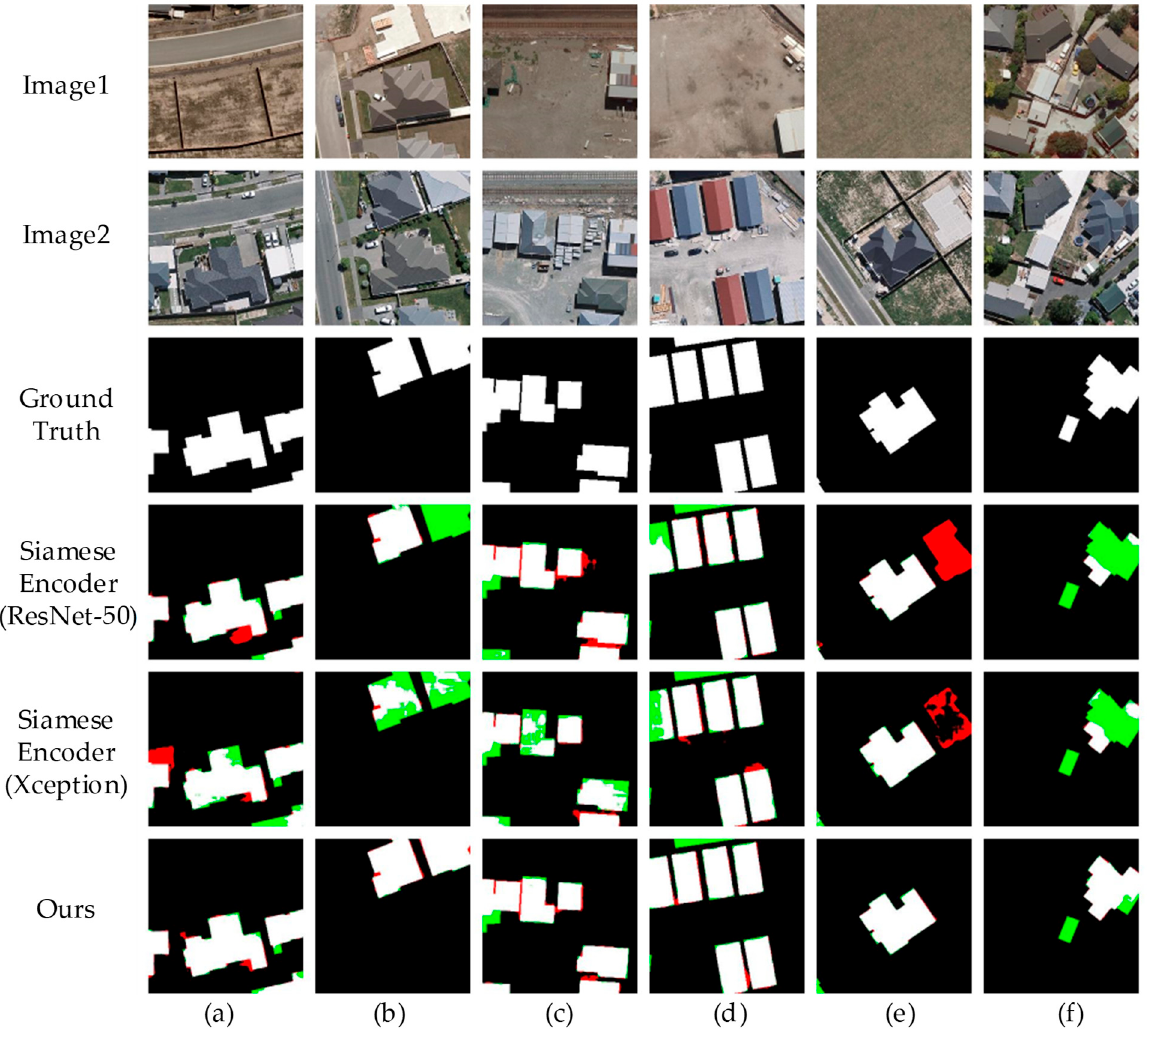
Figure 6. Illustrations of BuCD results on the WHUCD dataset using different backbones in the Siamese encoder. Six pairs of bitemporal images are shown from ( a – f ). White represents the correctly identified changing buildings. Additionally, red and green denote the false and missed predictions of changed buildings,